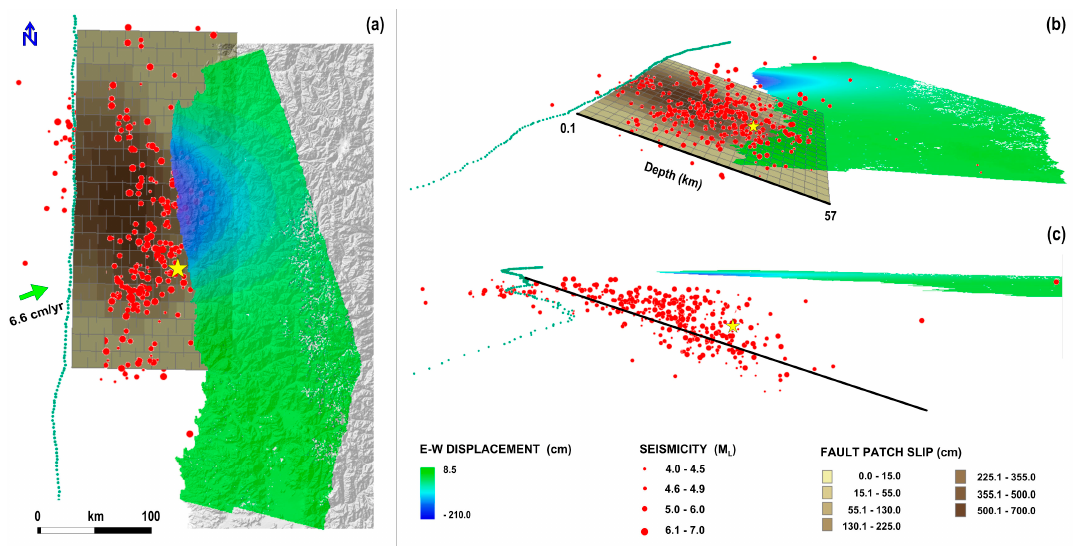
Figure 4. Coseismic slip distribution retrieved through the performed linear inversion. ( a ) Map view of the coseismic slip over 20 × 20 patches (with dimensions of 15 × 7.5 km 2 ); ( b ) and ( c ) report a 3D view of the fault patch slip. The aftershock distribution, with M > 4, spanning from 16 September (main shock) to 19 September (corresponding to the last day of temporal coverage of satellite data) are depicted with red circles. The yellow star is the main shock epicenter.